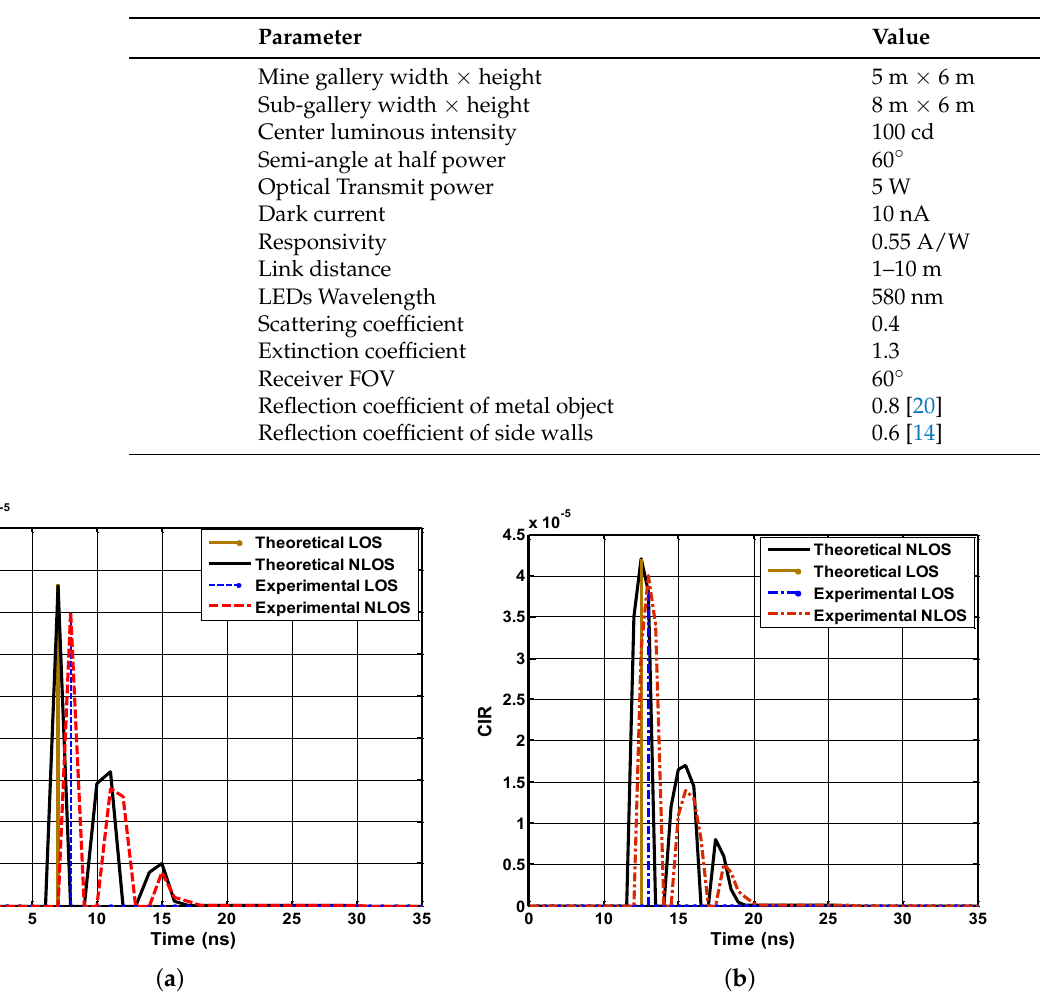
Figure 9. Channel impulse response (CIR) analysis for k = 3, ( a ) Mine gallery, and ( b )